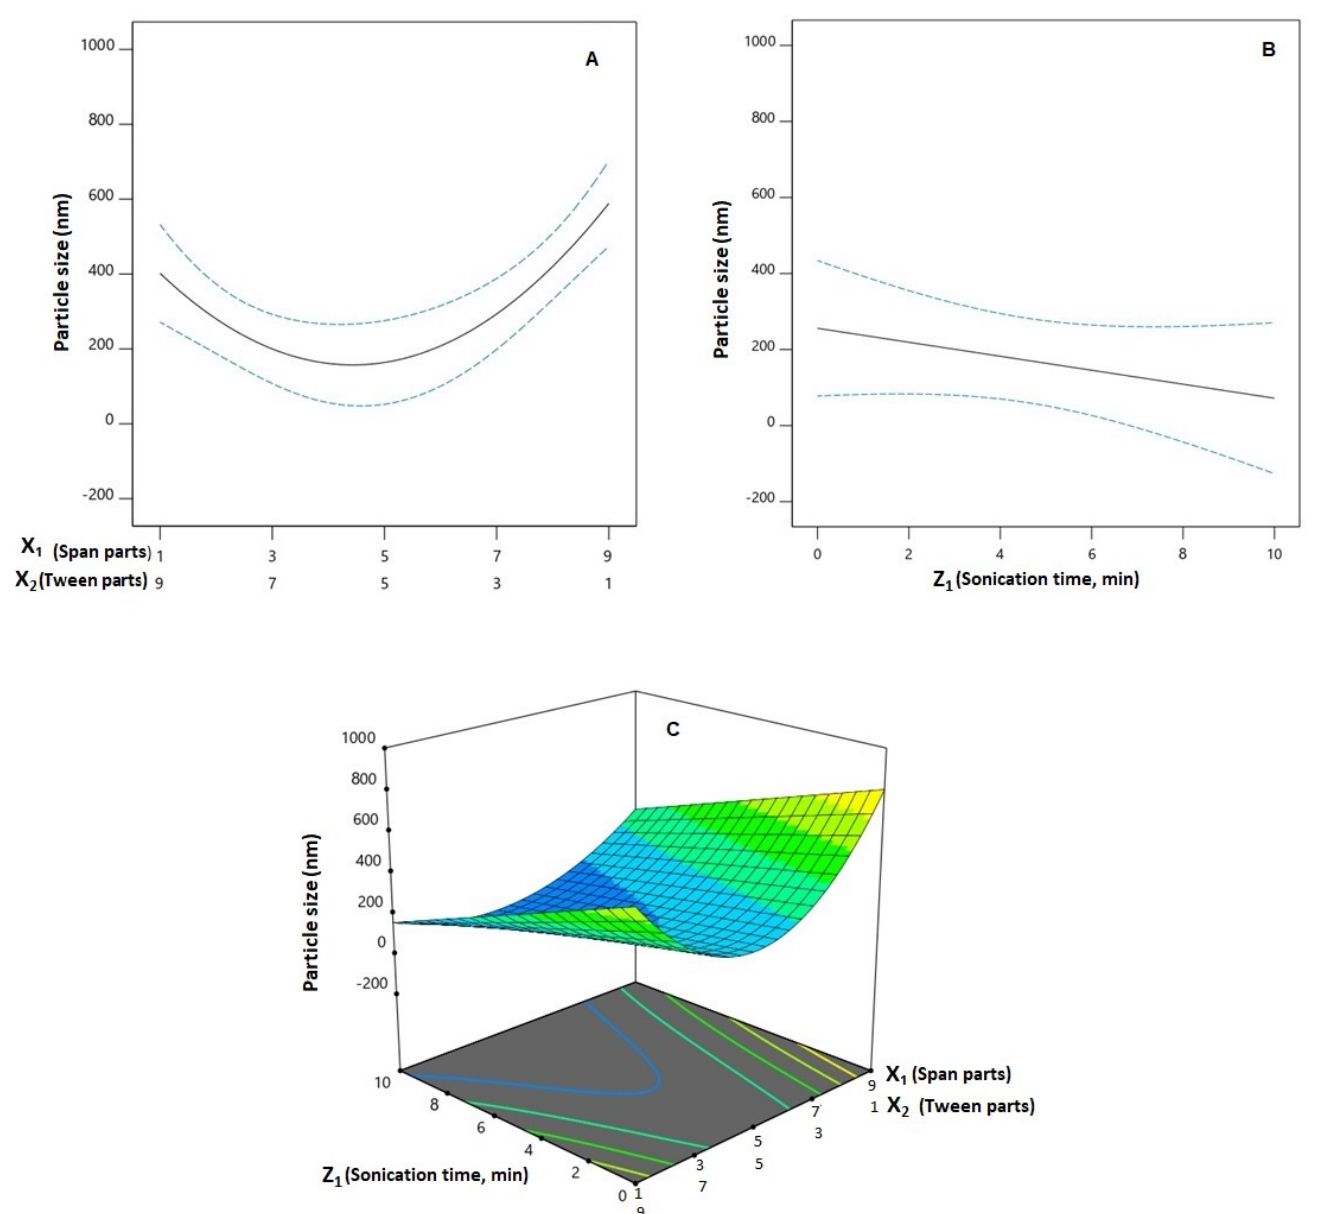
Figure 2. One-factor plots for the effect of the binary mixture components ( A ) and the sonication time ( B ) at the mid-values of the other variables on particle size (Y 1 ); three-dimensional mixture-process plot ( C ) for the interaction between mixture components and sonication time. Abbreviations : SMV, simvastatin; SPNs, spanlastics; X 1 , Span 20 parts; X 2 , Tween 60 parts (X 1 and X 2 add up to 10 parts)